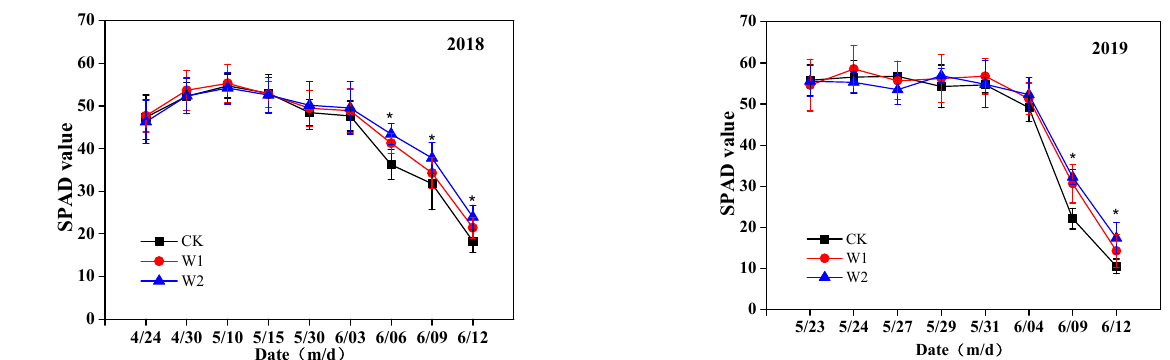
Figure 7. Relative content of chlorophyll of flag leaves during the grain filling stage under different treatments in 2018 and 2019. The values are the mean ± standard error ( n = 3). * = significant at a probability level of p < 0.05 according to the Least Significant Difference test. W1, W2, and CK represent 2.5 mm, 5 mm, and no irrigation treatments during dry-hot wind condition, respectively.